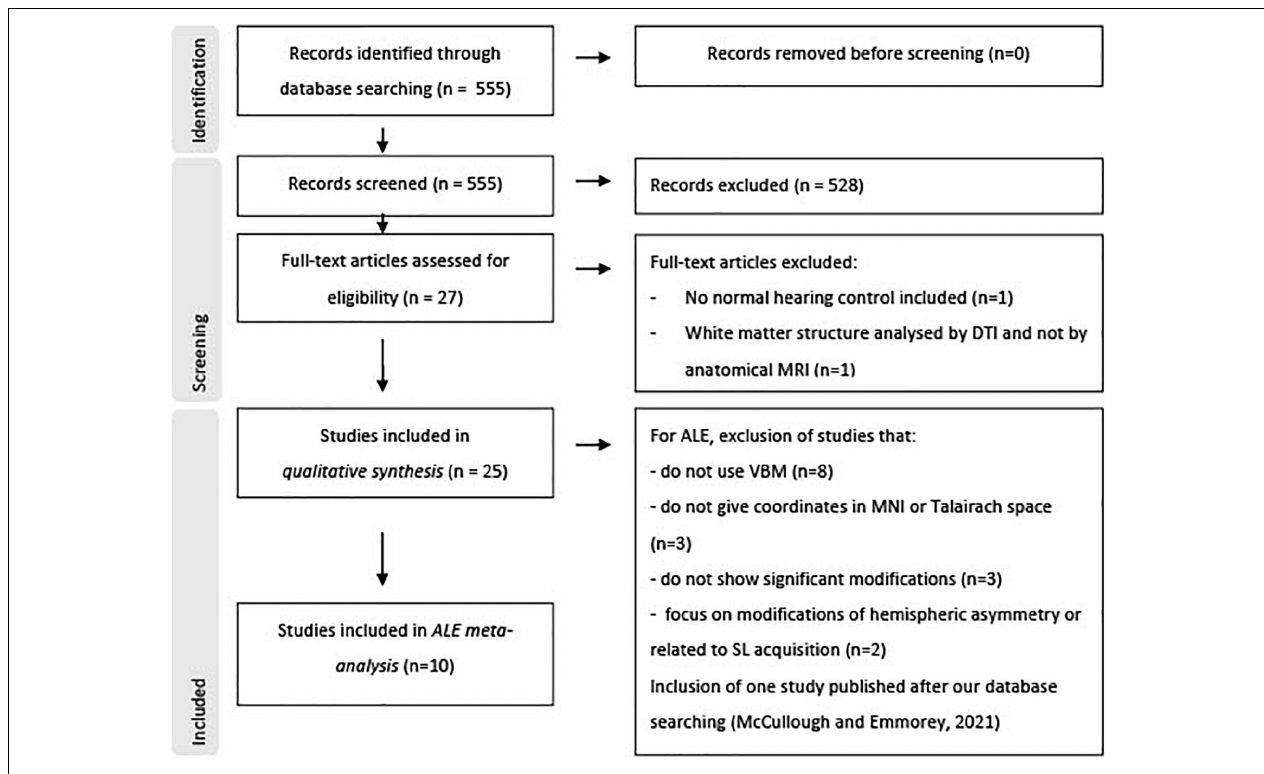
FIGURE 4 | Study flowchart according to PRISMA